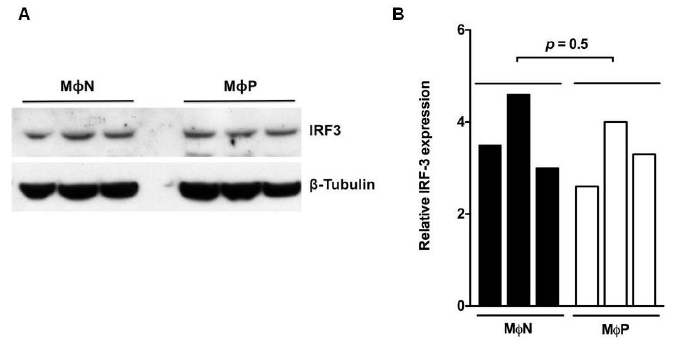
Figure 1. Total interferon regulatory factor 3 (IRF3) expression in persistently RSV-infected macrophages. ( A ) Total cell lysates from passages 86, 90 and 93 of non-infected macrophages (MΦN) and from passages 85, 86 and 88 of persistently RSV-infected macrophages (MΦP) were analyzed by western blot to detect total IRF3. The expression of β-tubulin protein was evaluated as loading control; ( B ) Semi-quantitative analysis was performed through densitometry with the software QuantityOne. Student- t test was performed to compare the average of the density values of the three passages of MΦN or MΦP. Results were reproduced in seven cellular passages analyzed (biological replicates).